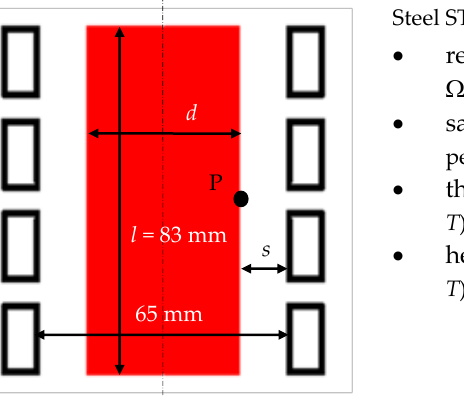
Figure 4. General coupling algorithm for electromagnetic and thermal calculations, taking into account interaction between the IHS and power source.